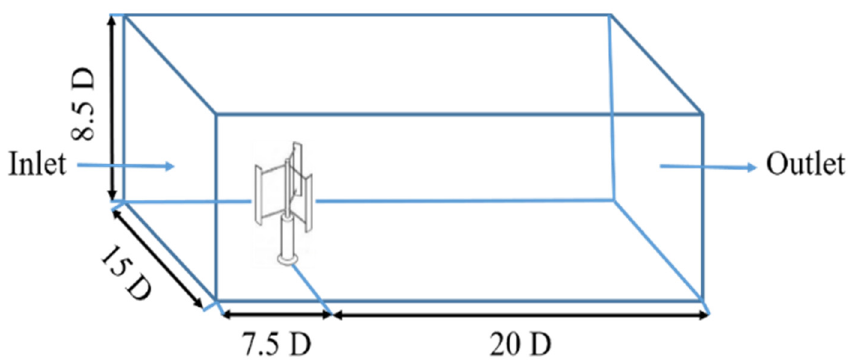
Figure 1. Computational domain for numerical simulation. Table 1 summarizes the geometric features of an H-Darrieus rotor. Table 1. Geometry of the turbine rotor.